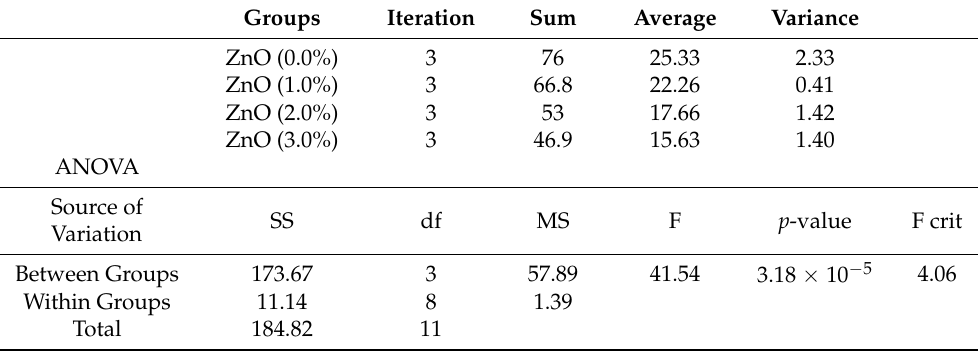
Table 4. Thickness swelling values of nano MDF containing UF-ZnO